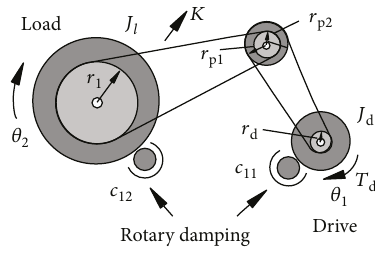
Figure 1: Schematic of the CMD system.